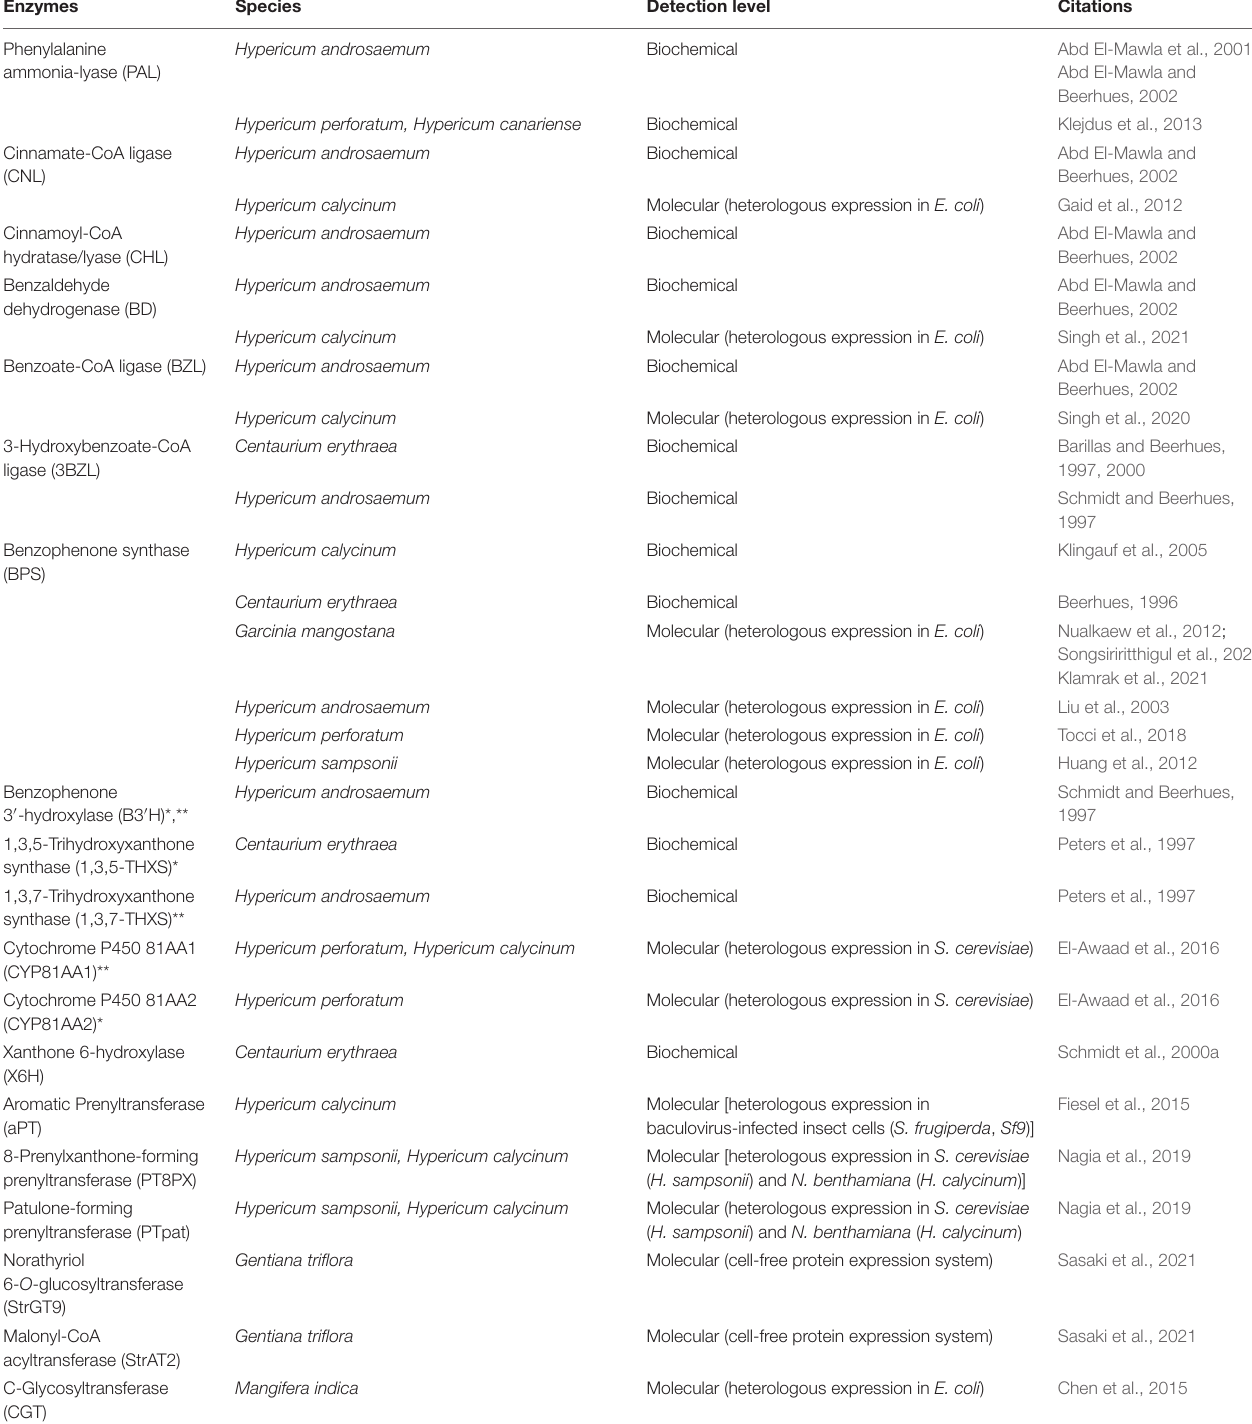
TABLE 1 | Enzymes involved in the xanthone pathway characterized from various xanthone-producing